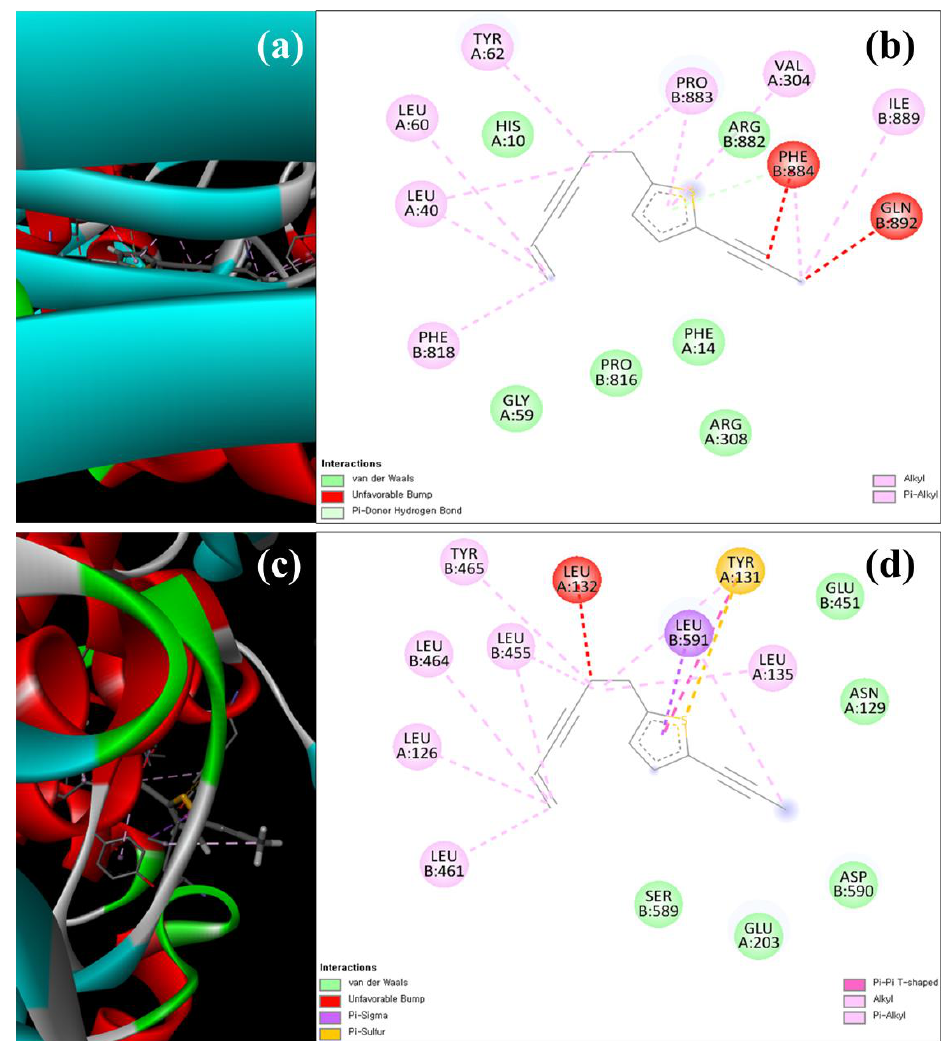
Figure 7. The structural overlay and 3D ( a , c ), and 2D ( b , d ) docking simulation of thiophene A with the crystal structure of NADPH oxidase ( a , b ) and D-alanine D-alanine ligase ( c , d ) during in silico molecular interaction analysis. The 3D simulations represent target proteins (thick tubes), ligands (thin tubes), and interaction forces/bonds (dotted tubes).